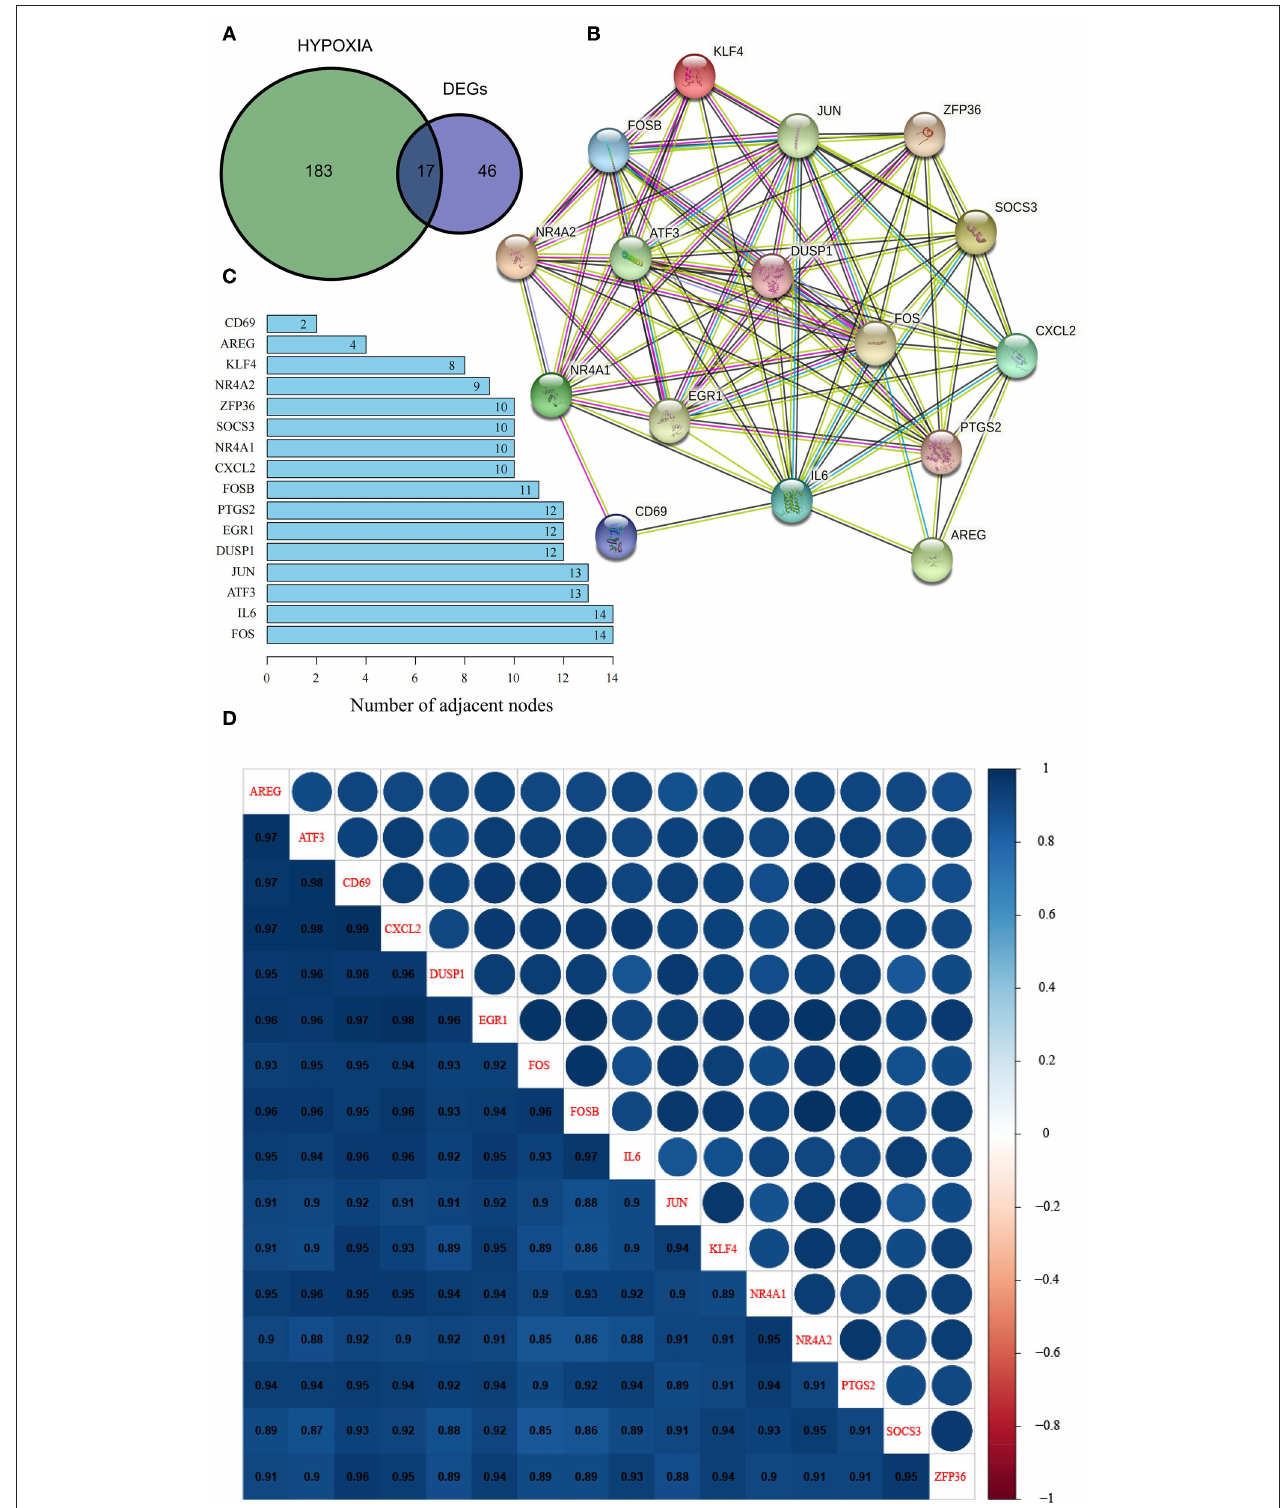
FIGURE 2 | Identification and characterization of hypoxia-related DEGs in OSA. (A) Venn diagram of overlapping hypoxia-related genes and DEGs. (B) PPI network of hypoxia-related DEGs. (C) Number of adjacent nodes of hypoxia-related DEGs in the PPI network. (D) Heatmap of correlations between hypoxia-related DEGs in the PPI